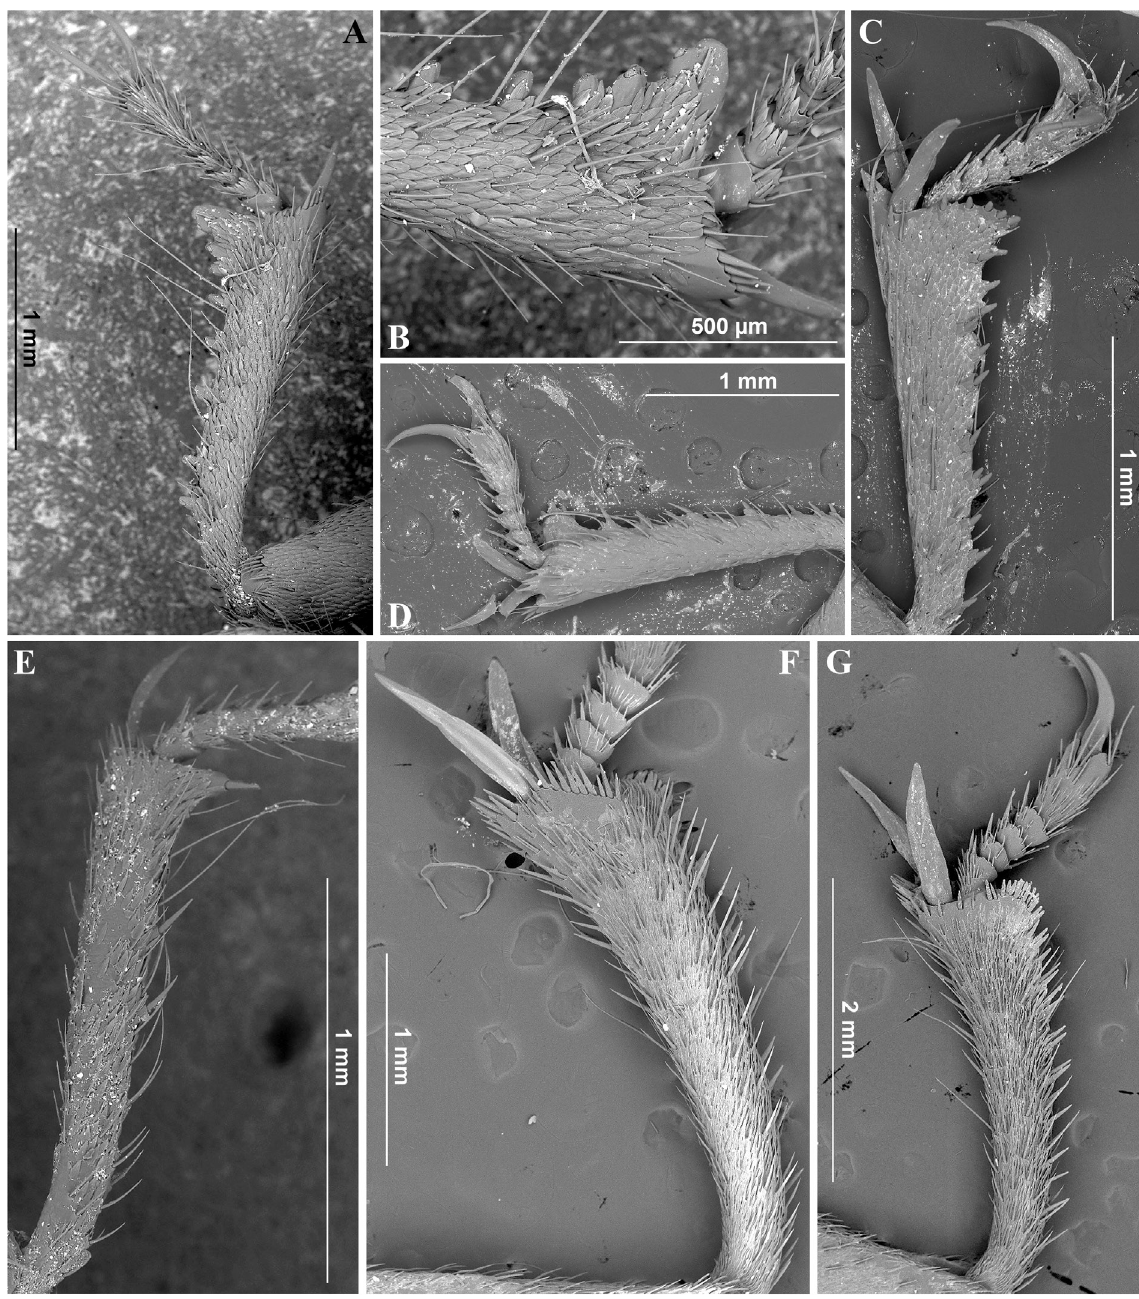
Fig. 27. Protibiae of Pimeliini, SEM. A . Apatopsis grombczewskii Semenov, 1891, ♀ (ZIN), dorsal view. B . Ditto, apical part. C . Habrobates vernalis Semenov, 1903, ♂, paralectotype (ZIN), ventral view. D . Ditto, dorsal view. E . Habrochiton vernus Semenov-Tjan-Shansky, 1907, dorsal view (ZIN). F . Mantichorula semenowi Reitter, 1889, ♂ (ZIN), ventral view. G . Ditto, dorsal